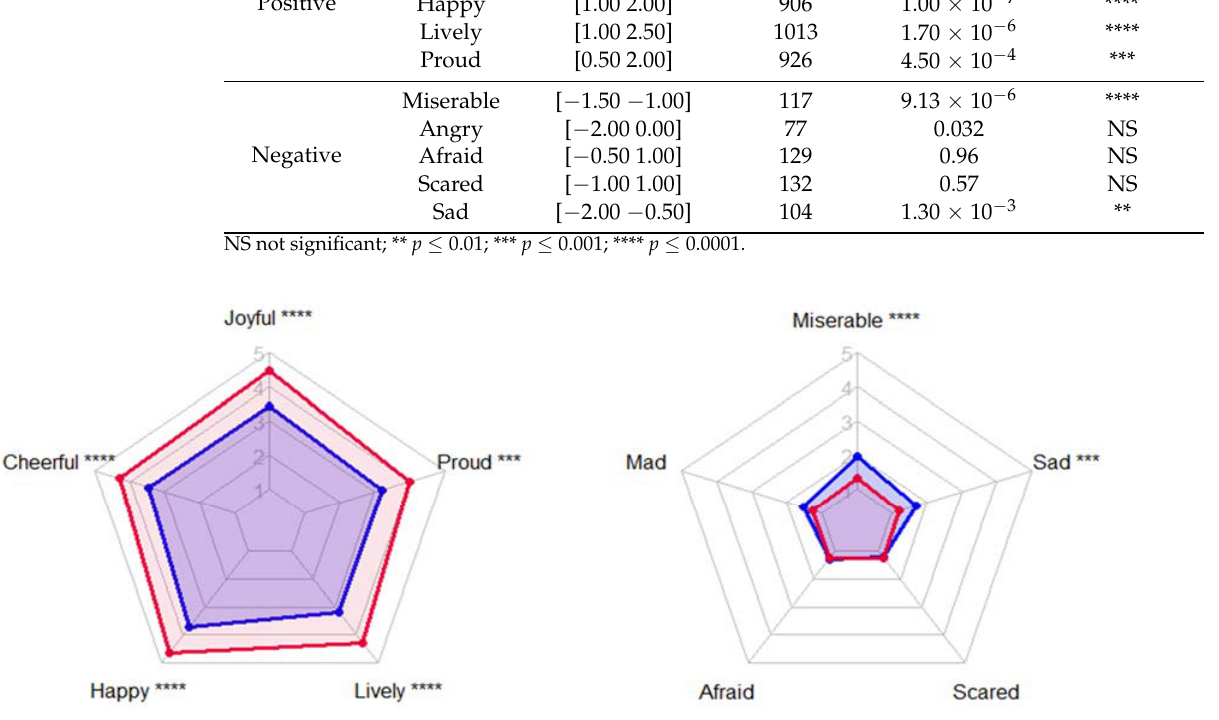
Figure 2. Means of the PANAS-C affect in the pre and post timing conditions. Pre-blue polygon, Post-red polygon. *** p ≤ 0.001; **** p ≤ 0.0001.